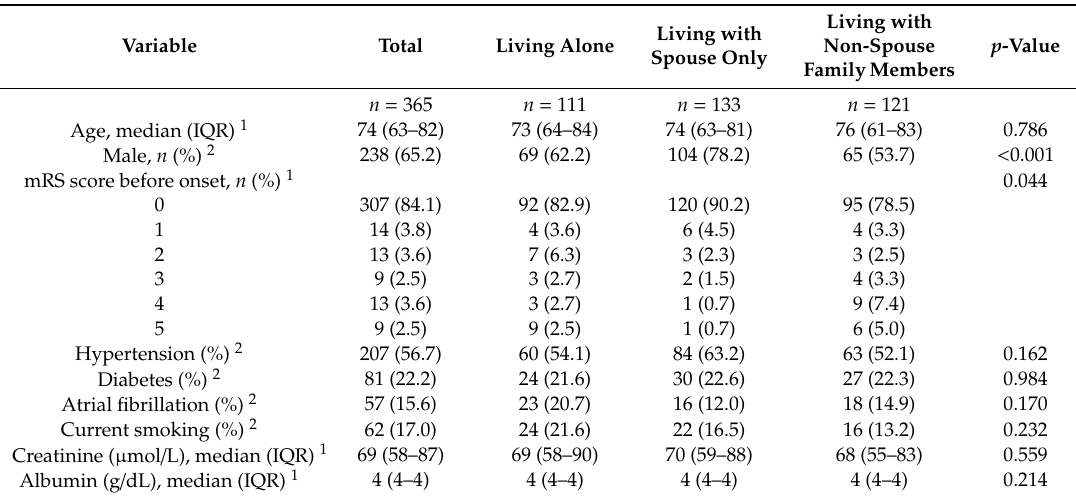
Figure 1. Flow diagram of the patient exclusion process. Table 1. Patients’